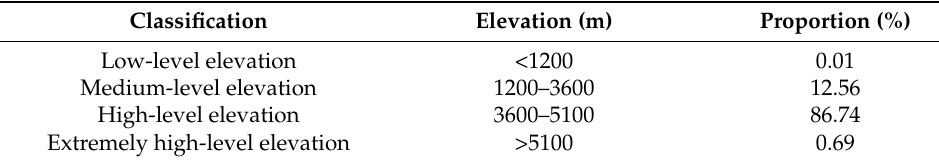
Table 3. Classification statistics according to elevation in Ganzi